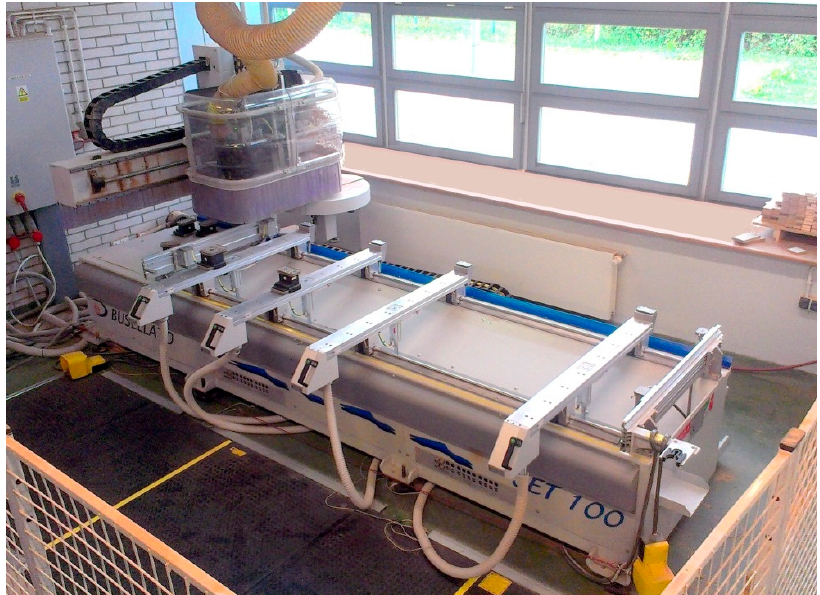
Figure 3. CNC router Busellatto Jet 130 used during the earlier, significantly reliable machinability testing [12].